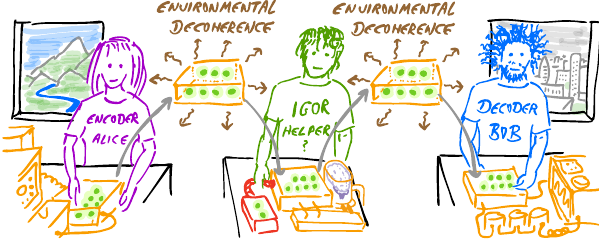
FIG. 2. Cartoon illustration of the protocol for assessing the efficacy of our QEC cycle. Strictly speaking, Alice and Bob have ideal experimental equipment capable of encoding and decoding a quantum state perfectly, whereas only Igor has the imperfec- tions of our real laboratory setting. The stages of the protocol are detailed in Table